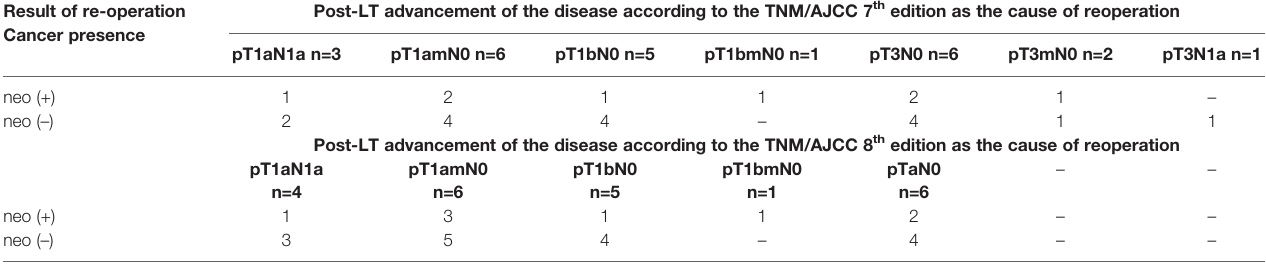
TABLE 3 | Results of reoperation due to a higher stage of the disease after LT in 24 patients from the PGcT1aN0M0 group. Result of re-operation Cancer